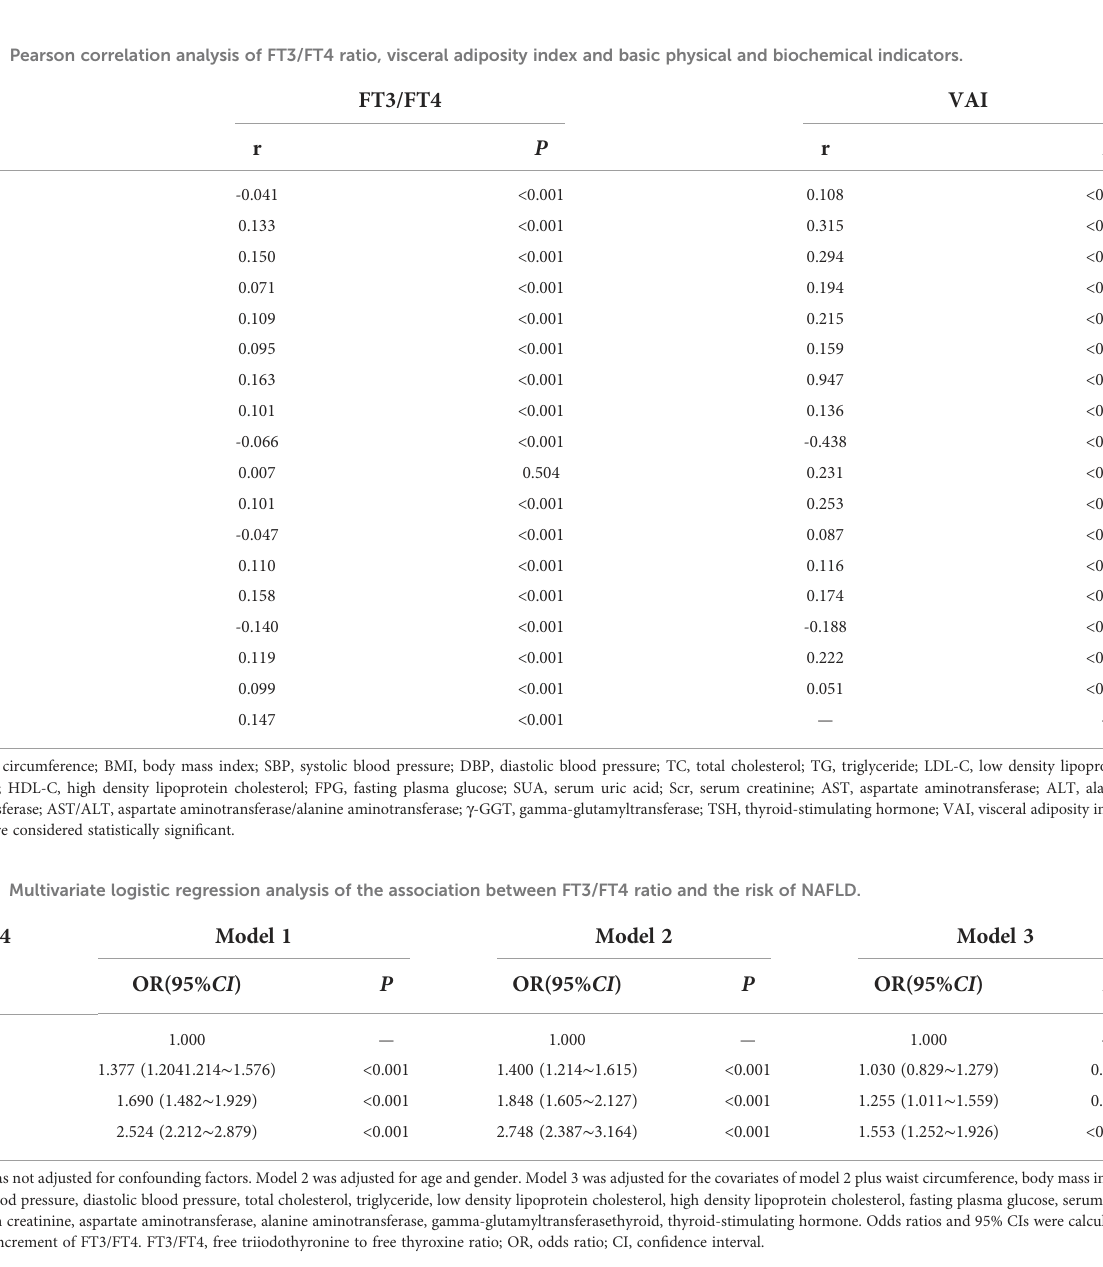
TABLE 4 Pearson correlation analysis of FT3/FT4 ratio, visceral adiposity index and basic physical and biochemical indicators.